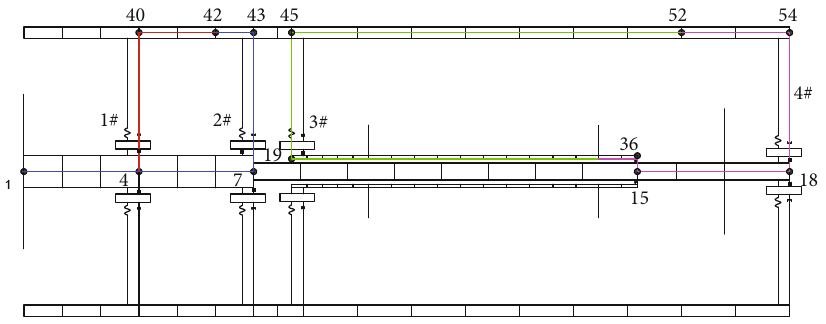
Figure 8: Transfer paths for the vibration load in the simulated engine.